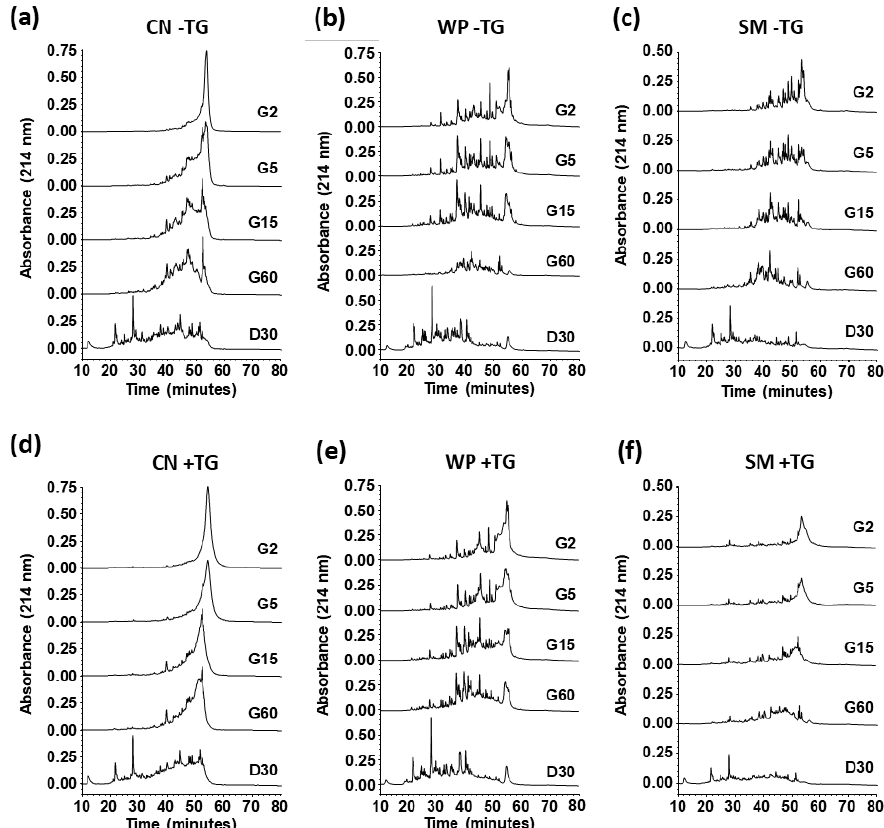
Figure 6. Digestibility of TG cross-linked milk proteins. RP-HPLC patterns of untreated ( − TG; a , b , c ) and TG cross-linked (+TG; d , e , f ) casein (CN; a , d ), whey proteins (WP; b , e ), and skim milk (SM; c , f ), after 2 (G2), 5 (G5), 15 (G15), and 60 (G60) min of simulated gastric digestion with pepsin, and subsequent duodenal digestion with Corolase PP for 30 min (D30). Table 2. IgE binding to untreated and TG cross-linked slim milk (SM), casein (CN), and whey proteins (WP), before and after gastric and duodenal digestion, as estimated by inhibition ELISA with sera from milk allergic patients (EC50, µ